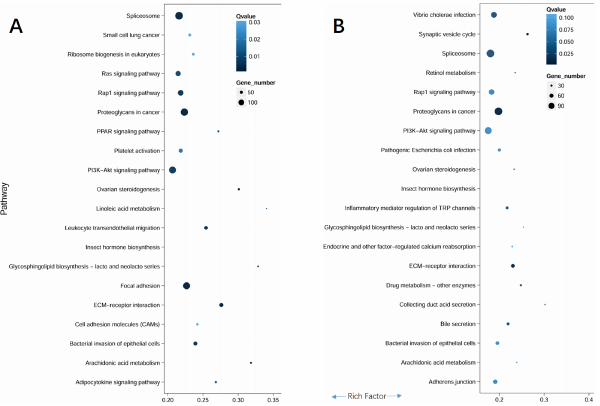
Fig 4. Scatter diagram of pathway enrichment for differentially expressed genes (DEGs) following 48 h infection of WSSV (A) and poly I:C (B). The top 20 pathways were